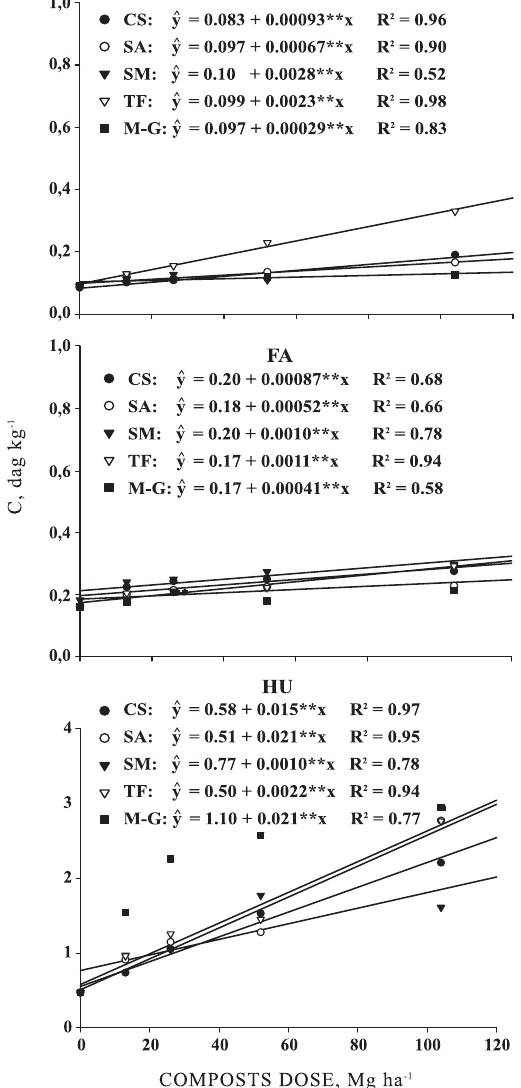
Figure 2. Contents of humic acids (HA), fulvic acids (FA) and humin (HU) in soil subjected to increasing doses of different composts. SC: simple compost; AS: SC + NPK, where N: ammonium sulphate; SM: SC + powder from serpentinite and micaschist rocks; FC: filter cake + sugarcane bagasse; M-G: castor oil plant residue + sugarcane